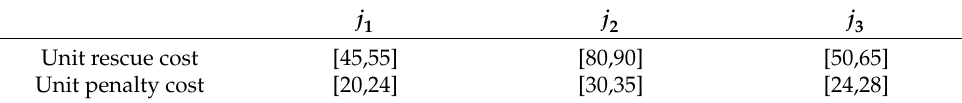
Table 4. Unit rescue cost and unit penalty cost of relief supplies (Yuan/100 km).